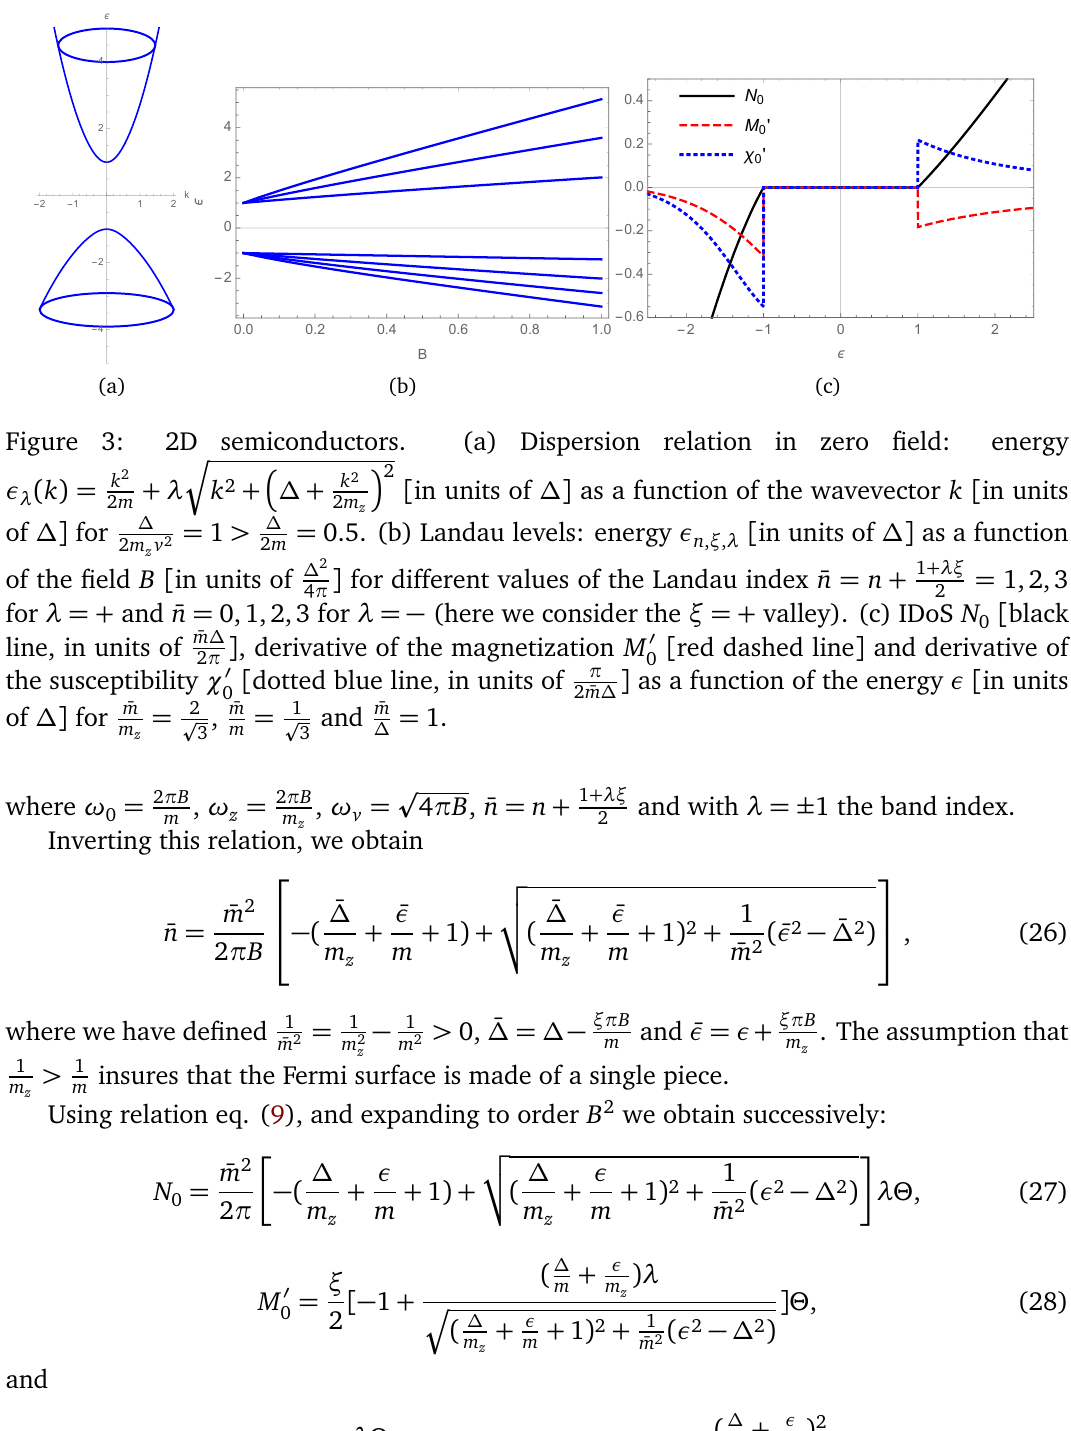
= 1,2,3 2 [ black 0